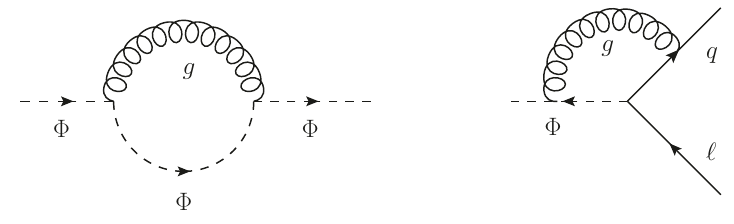
Figure 2 . One-loop diagrams leading to the renormalization of the LQ mass and the LQ coupling to quarks and